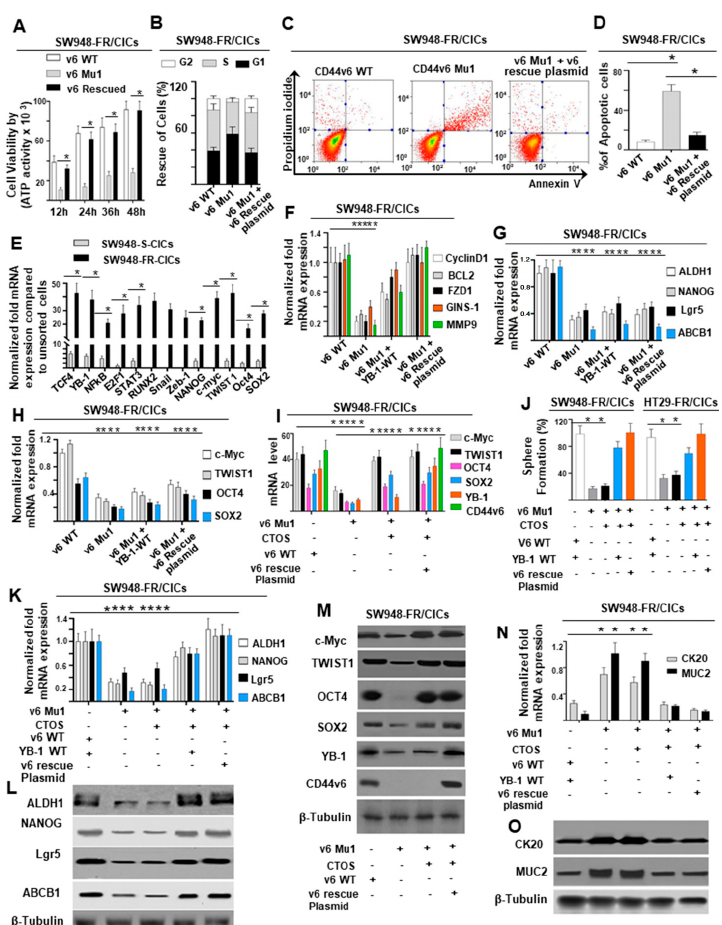
Figure 4. Requirement of CD44v6 and YB-1 for the stemness of SW948-FR CICs after acquisition of FOLFOX resistance. ( A ) The effects are shown of CD44v6 knockout on cell viability (using ATP Glo method) of CD44v6 Mu1, CD44v6 WT, and on CD44v6-rescue SW948-FR/CICs (1 × 10 3 cells/well of 96-well plate) which were cultured for the indicated times. The time point 0 h represents the number of inoculated cells (data not shown). ( B ) The influence of CD44v6 on cell cycle of CD44v6 Mu1, CD44v6 WT, and CD44v6-rescue SW948-FR CICs are shown. Cells (1 × 10 4 ) were cultured for 48 h, and the percentage of cells in G1, S, and G2 phases of cell cycles were examined with flow cytometry. ( C , D ) Indicated SW948-FR CICs were seeded into a 6-well plate at 1 × 10 5 cells/well and cultured for 48 h. The extents of apoptosis of CICs in the cultures were examined by flow cytometry. ( E ) A ChIP assay was performed with chromatin from SW948-FR CICs using an anti-CD44v6 antibody. The immunoprecipitated DNA was amplified by PCR and subcloned. A total of 13 clones were sequenced. Computer-based analysis revealed the presence of various consensus binding sites for common transcription factors in these DNA sequences (see Supplemental Table S2). QPCR analyses show the expressions of these 13 transcription factors in CICs of “S’ and “FR” cells of SW948. ( F ) Expressions are shown for antiapoptosis/stemness-related genes in v6 WT CICs, v6 Mu1 CICs, YB-1 WT overexpressed v6 Mu1 CICs, and in CD44v6 rescue plasmids overexpressed v6 Mu1 CICs. QPCR was conducted to detect the expression levels of the genes. ( G , H ) Influence of v6-rescue plasmid into v6 Mu1 CICs for stemness-related gene expressions ( G ) and stemness-related TFs (c-Myc, TWIST1, OCT4, and SOX2) ( H ) were measured by QPCR. ( I , M ) The CD44v6-WT plasmid, or the constructs of the “CTOS” (c-Myc, TWIST1, OCT4, and SOX2) TFs either alone or with CD44v6-rescue plasmid, were transfected into the v6 Mu1 SW948-FR CICs. At 72 h after transfection, QPCR ( I ) or Western blot ( M ) analyses were done to examine the expression levels of these transcription factors. ( J , K , L , N , O ) Effects of simultaneous expressions of the “CTOS” with the CD44v6-rescue plasmid are shown on sphere formation ( J ), on the expressions of indicated stemness-related genes and protein ( K , L ), and on differentiation-related genes and protein ( N , O ) in v6 Mu1 SW948-FR CICs. The experiments were biologically repeated for three times. QPCR data represent means ± SD; n = 4–6; * p < 0.05 compared to vector control, WT control, or vehicle cell control group. Western blot data are representative of three